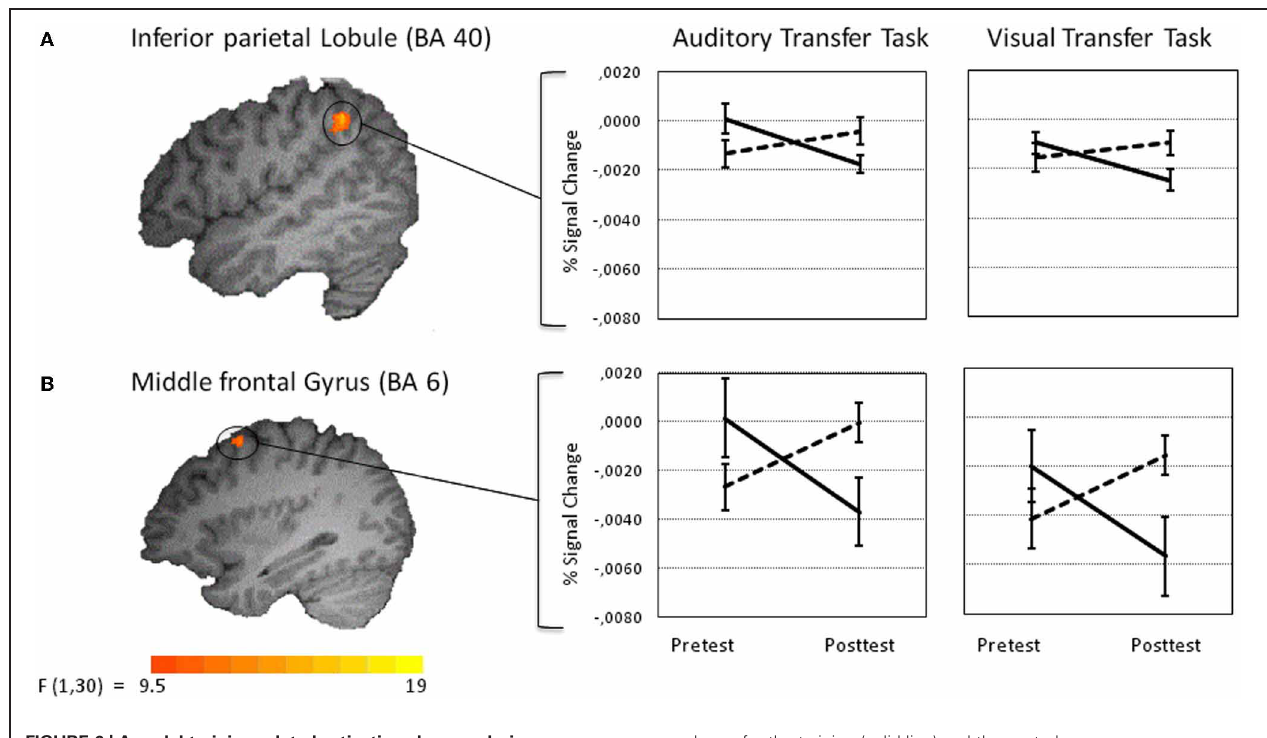
FIGURE 6 | Amodal training-related activation changes during the performance of the auditory (left panel) and visual transfer task (right panel). Percent signal change values of functional volumes of interests thresholded at p < 0 . 005 (135 voxel extend)